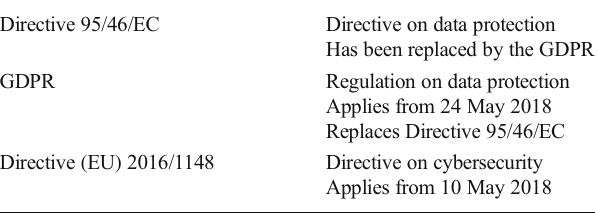
Regulatory framework in the EU on data